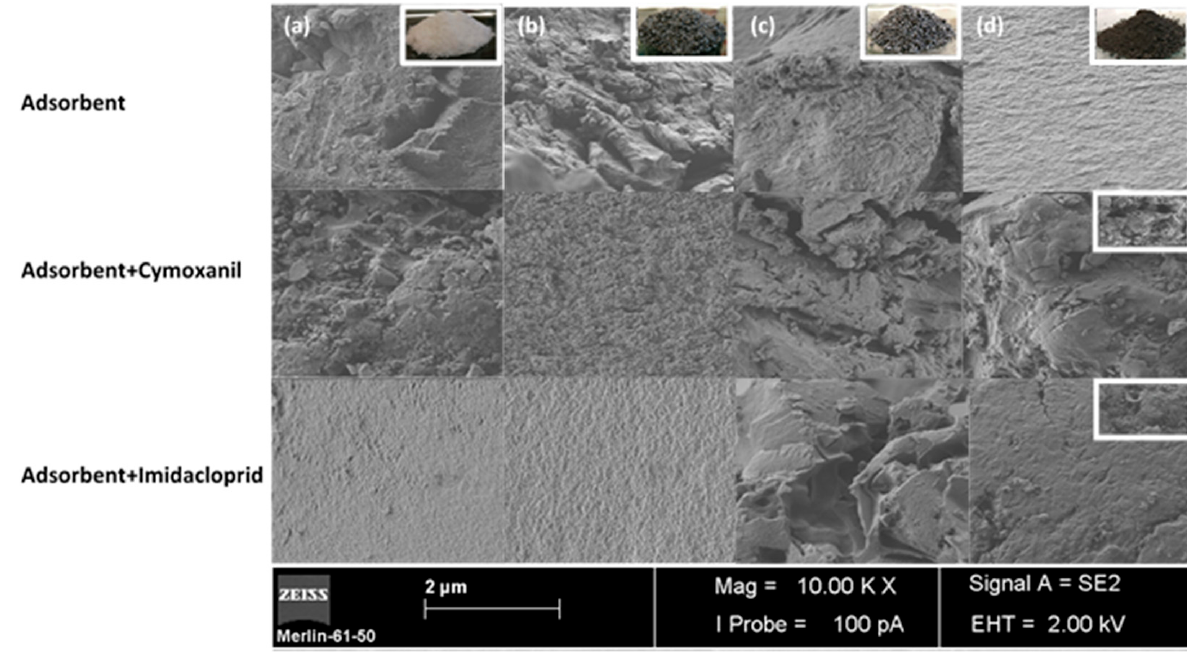
Figure 6. SEM micrographs of sorbent materials before (top row) and after 24 h in contact with aqueous solutions of cymoxanil (middle row) and imidacloprid (bottom row), respectively (magnification ×10,000). ( a ) PCD); ( b ) PCD/AC 5% ; ( c ) PCD/AC 10% and ( d ) AC. Inset figures are photos of the adsorbents.